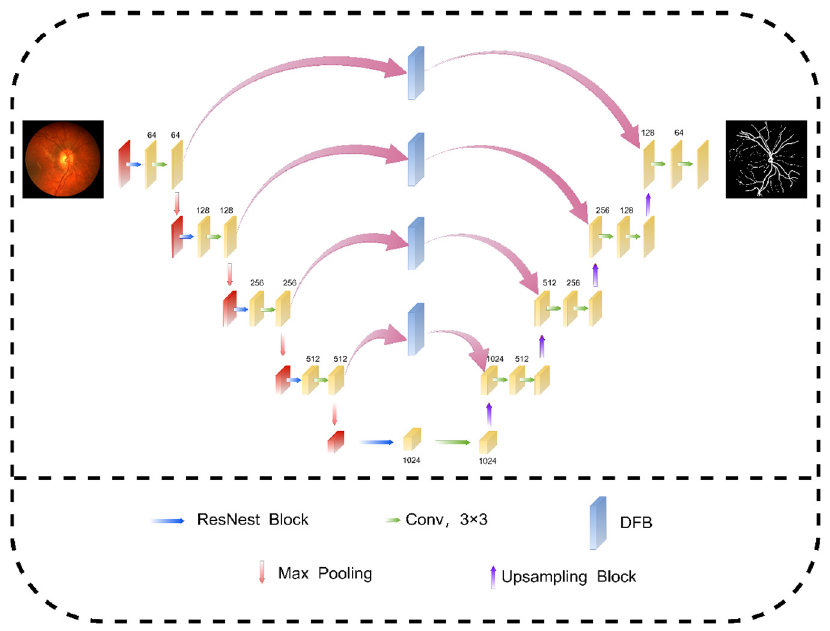
Figure 1. Network structure based on U-Net-improved segmentation network.